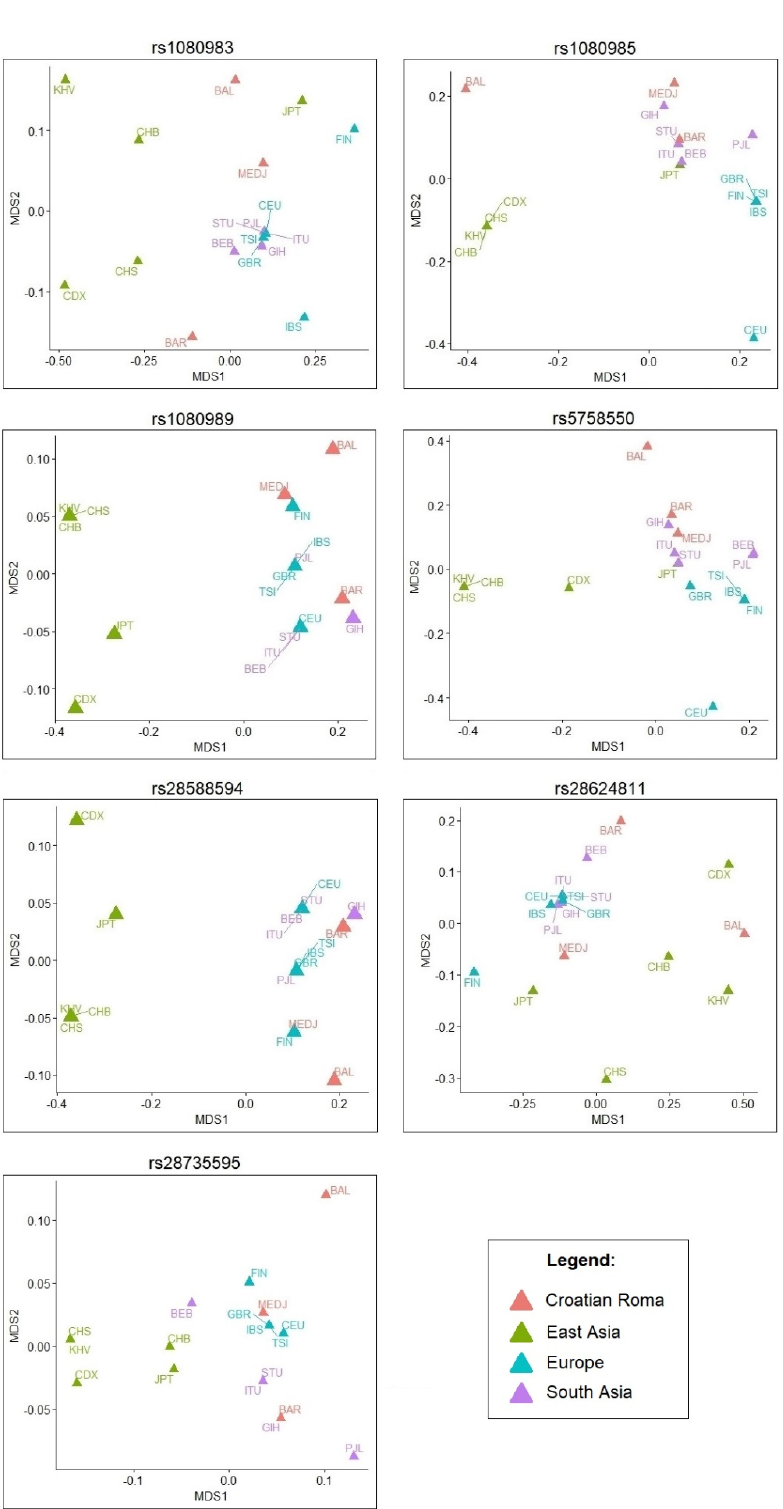
Figure 2. Multidimensional scaling plots (MDS) of Spearman’s correlation matrices for linkage disequilibrium (LD) between the CYP2D6 promoter and enhancer SNPs and star allele-defining SNPs in the European, South Asian, East Asian and Croatian Roma populations.